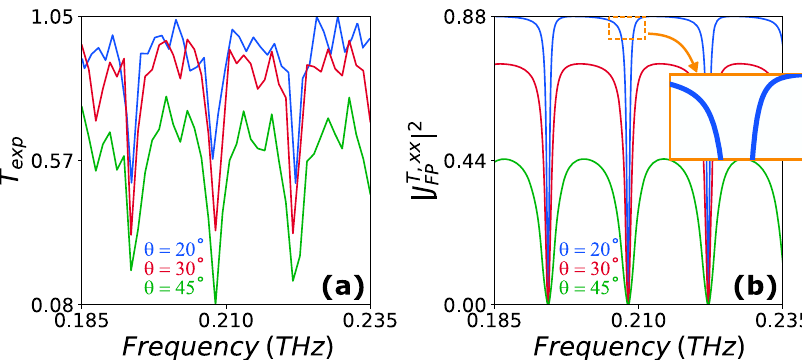
Fig. 2 Experimental and theoretical comparison. a Measured and b computed transmission spectra for p = 35 μ m, a = 25 μ m, h = 10 μ m and d = 1, 08 cm where p , a and h are the MWGM ’ s period, aperture width and thickness, respectively, and d is the distance between them. The inset in ( b ) highlights the slight asymmetry in the Fano line